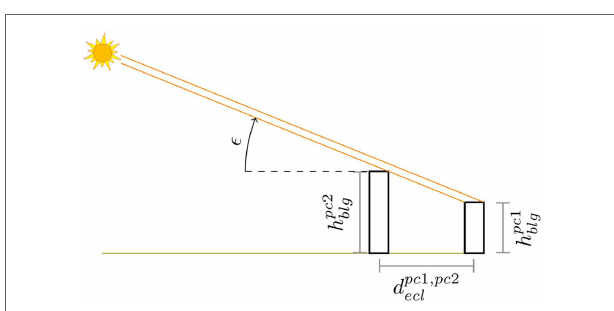
FIGURE 3 | Calculation of obstruction to sun